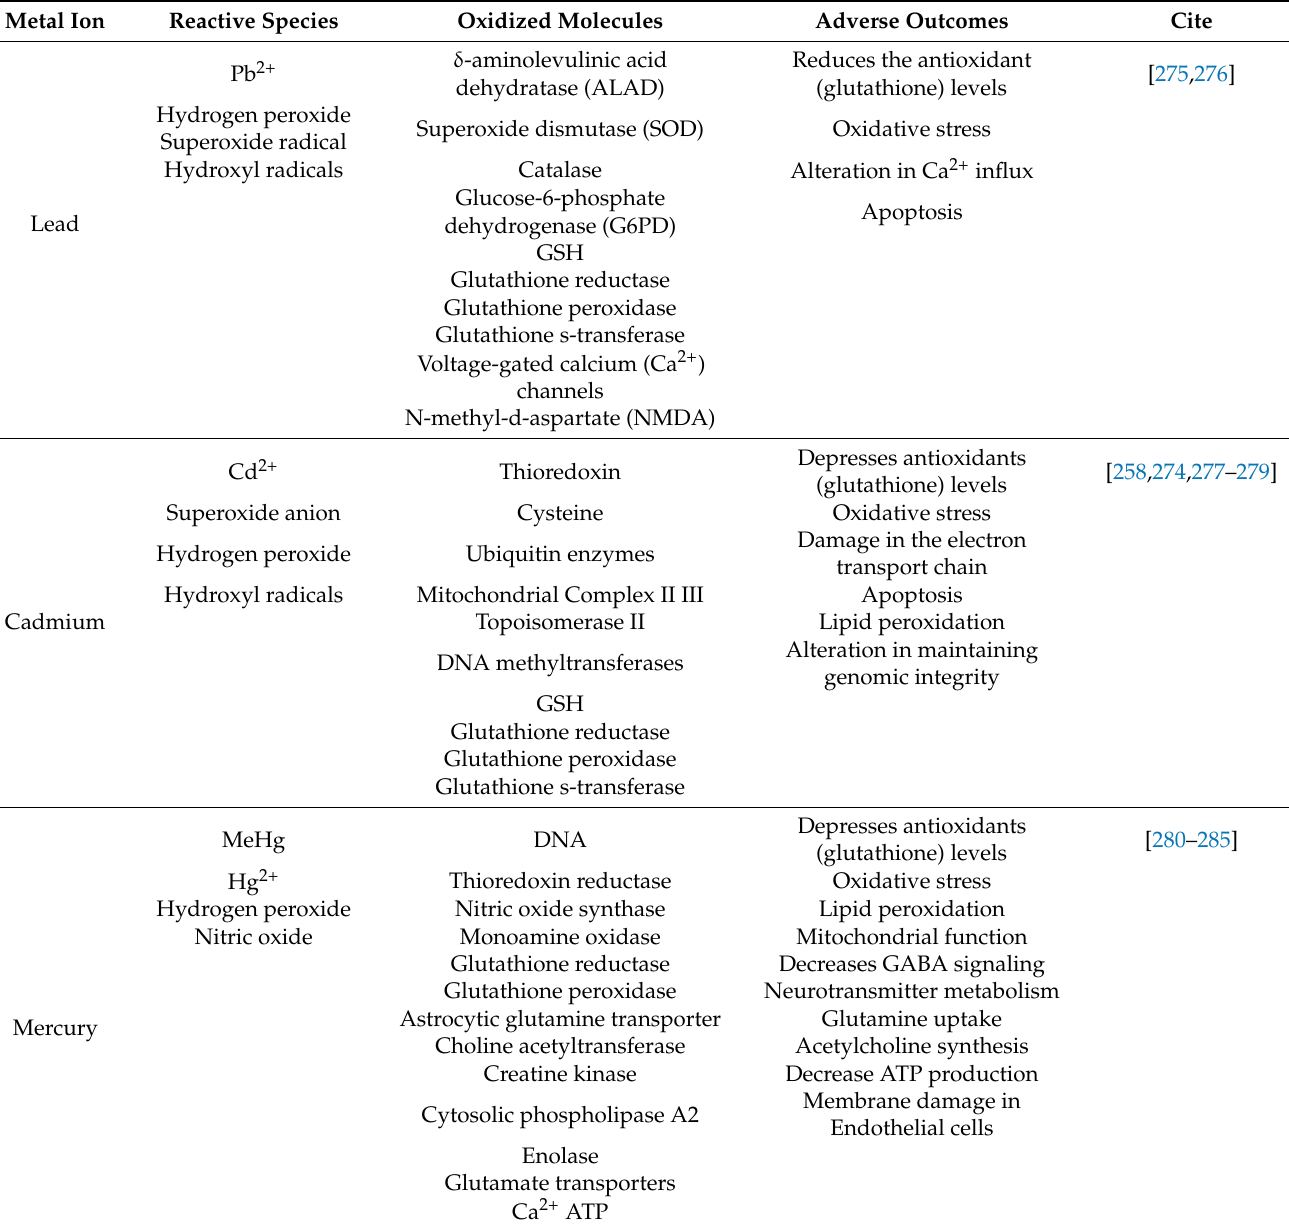
Table 2. Metal ions and ROS/NOS adversely oxidize neuroproteins and lipid